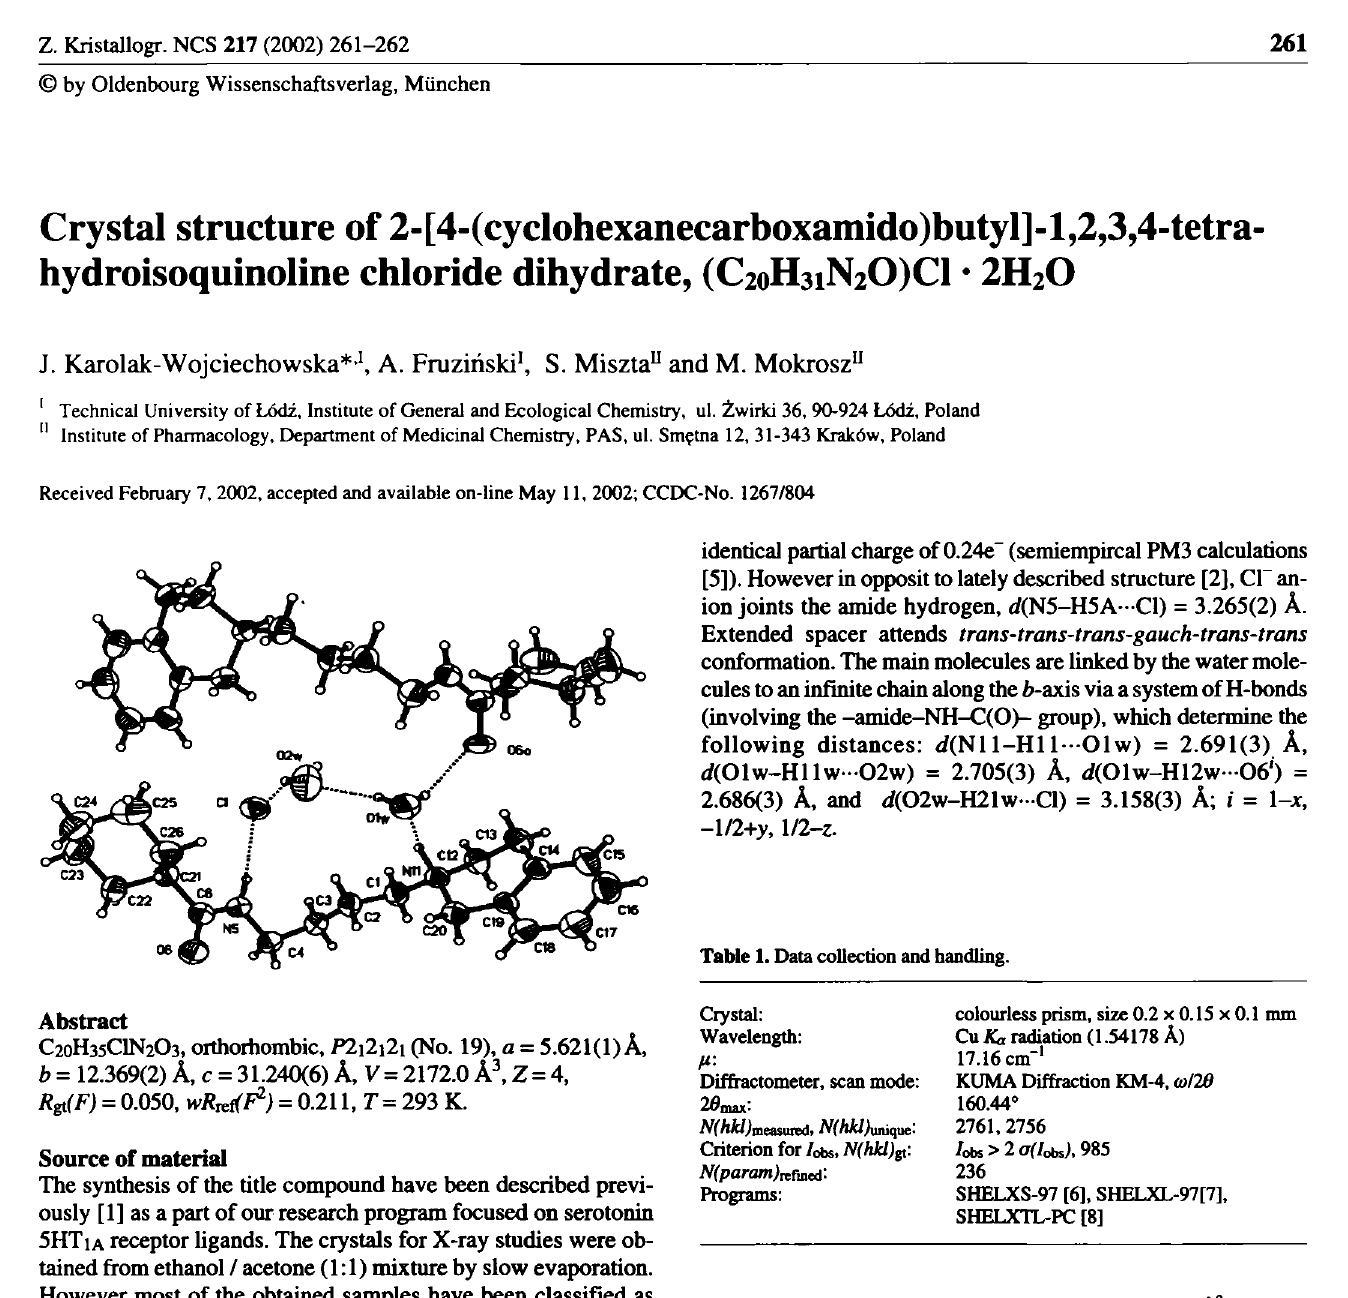
Table 2. Atomic coordinates and displacement parameters (in Â 2